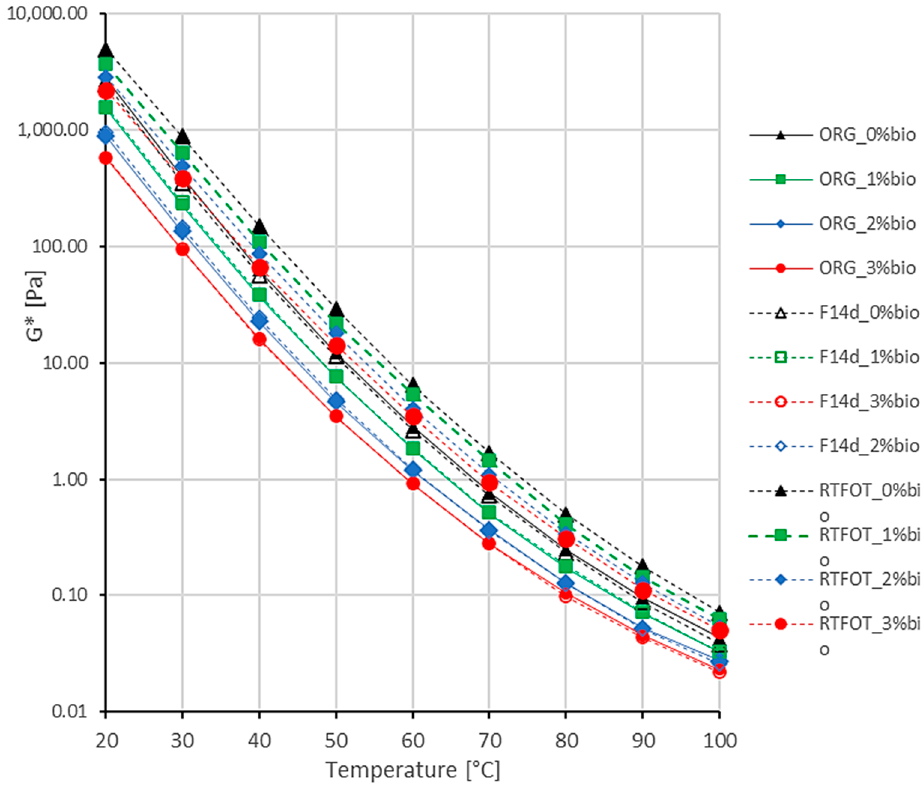
Figure 1. Complex modulus G* results of the 50/70 paving-grade bitumen. Table 3. Comparison of G* modulus results in 20 °C of the 50/70 paving-grade bitumen.